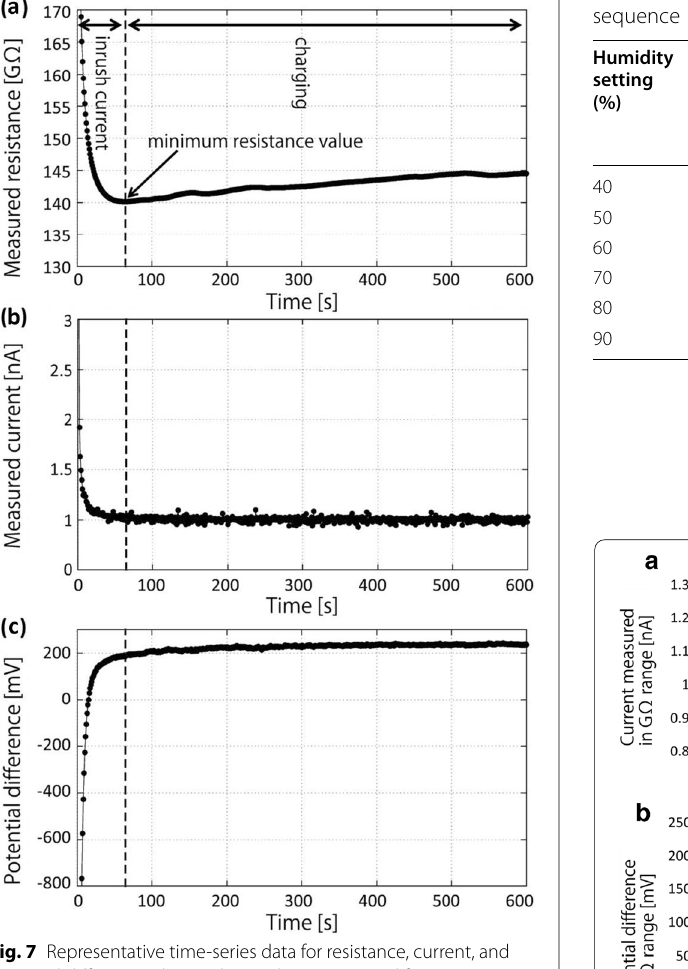
Table 3 Stability of temperature and relative humidity in each